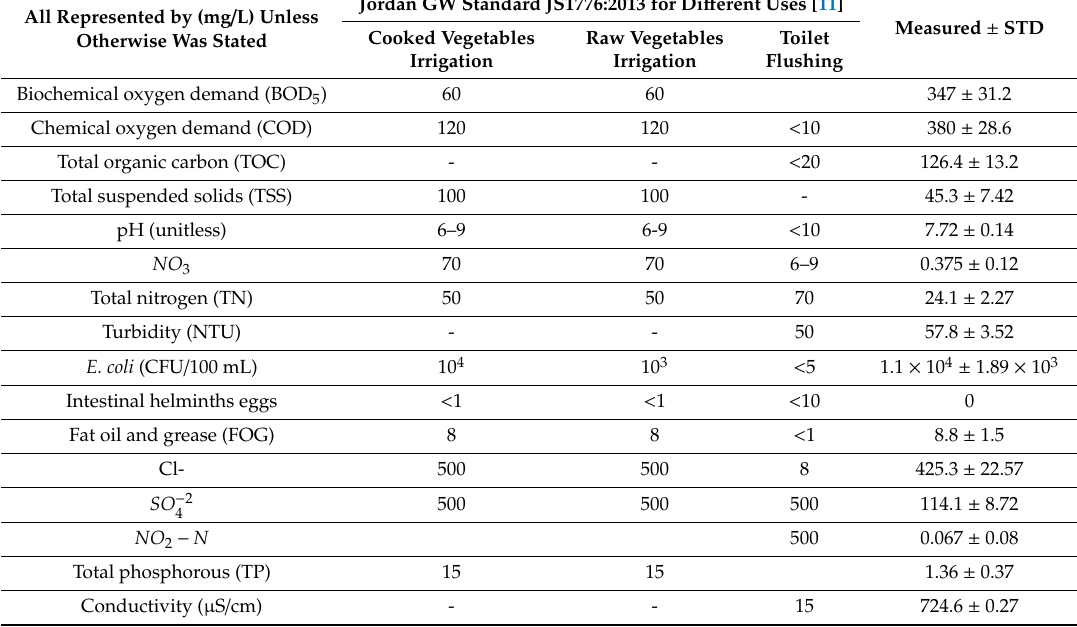
Measured ± STD Cooked Vegetables